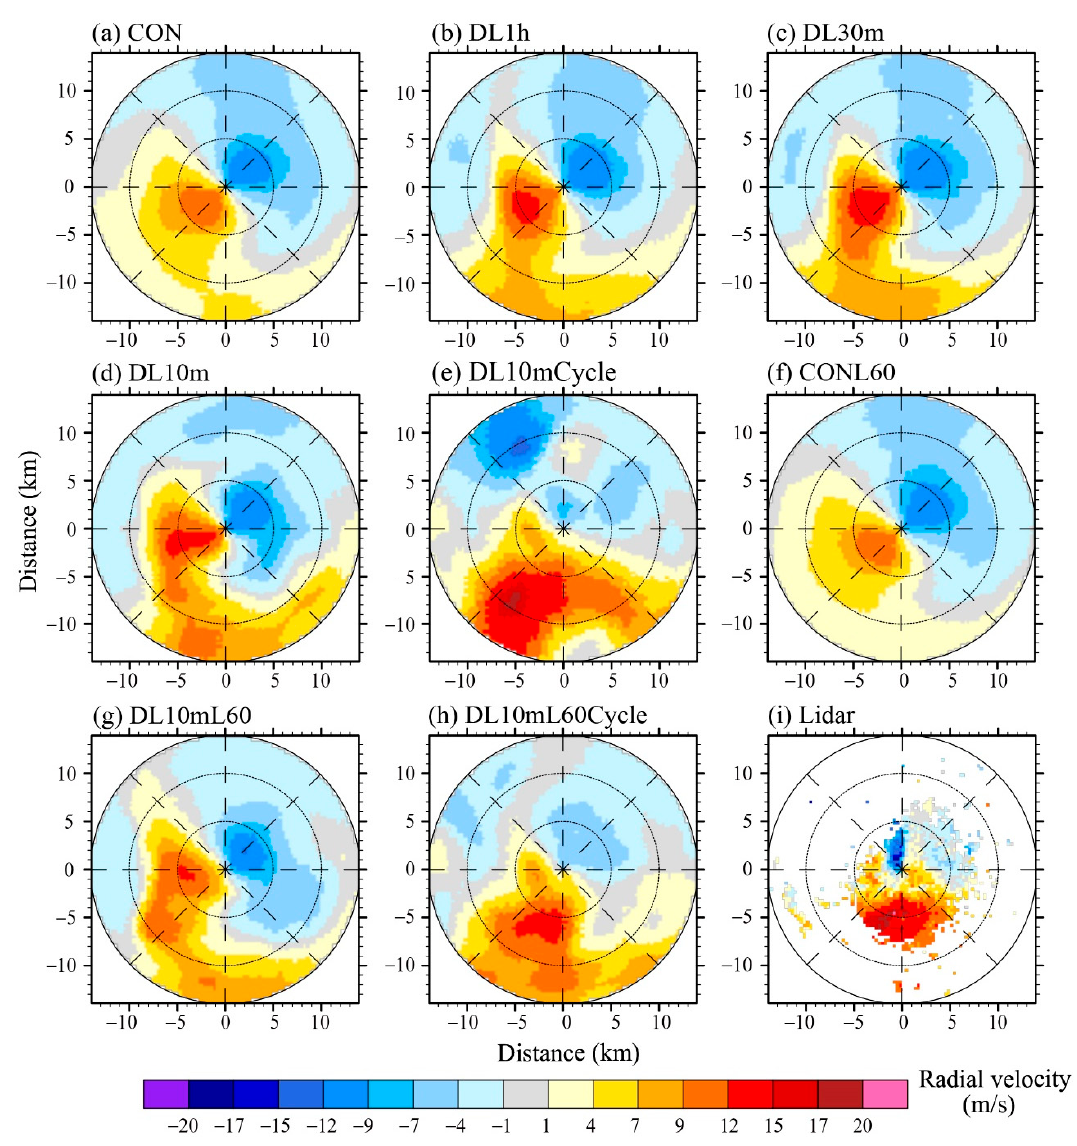
Figure 6. Vrs estimated from experiments ( a ) CON, ( b ) DL1h, ( c ) DL30m, ( d ) DL10m, ( e ) DL10mCycle, ( f ) CONL60, ( g ) DL10mL60, and ( h ) DL10mL60Cycle, and ( i ) observations at a six-degree elevation at 11:30 UTC.